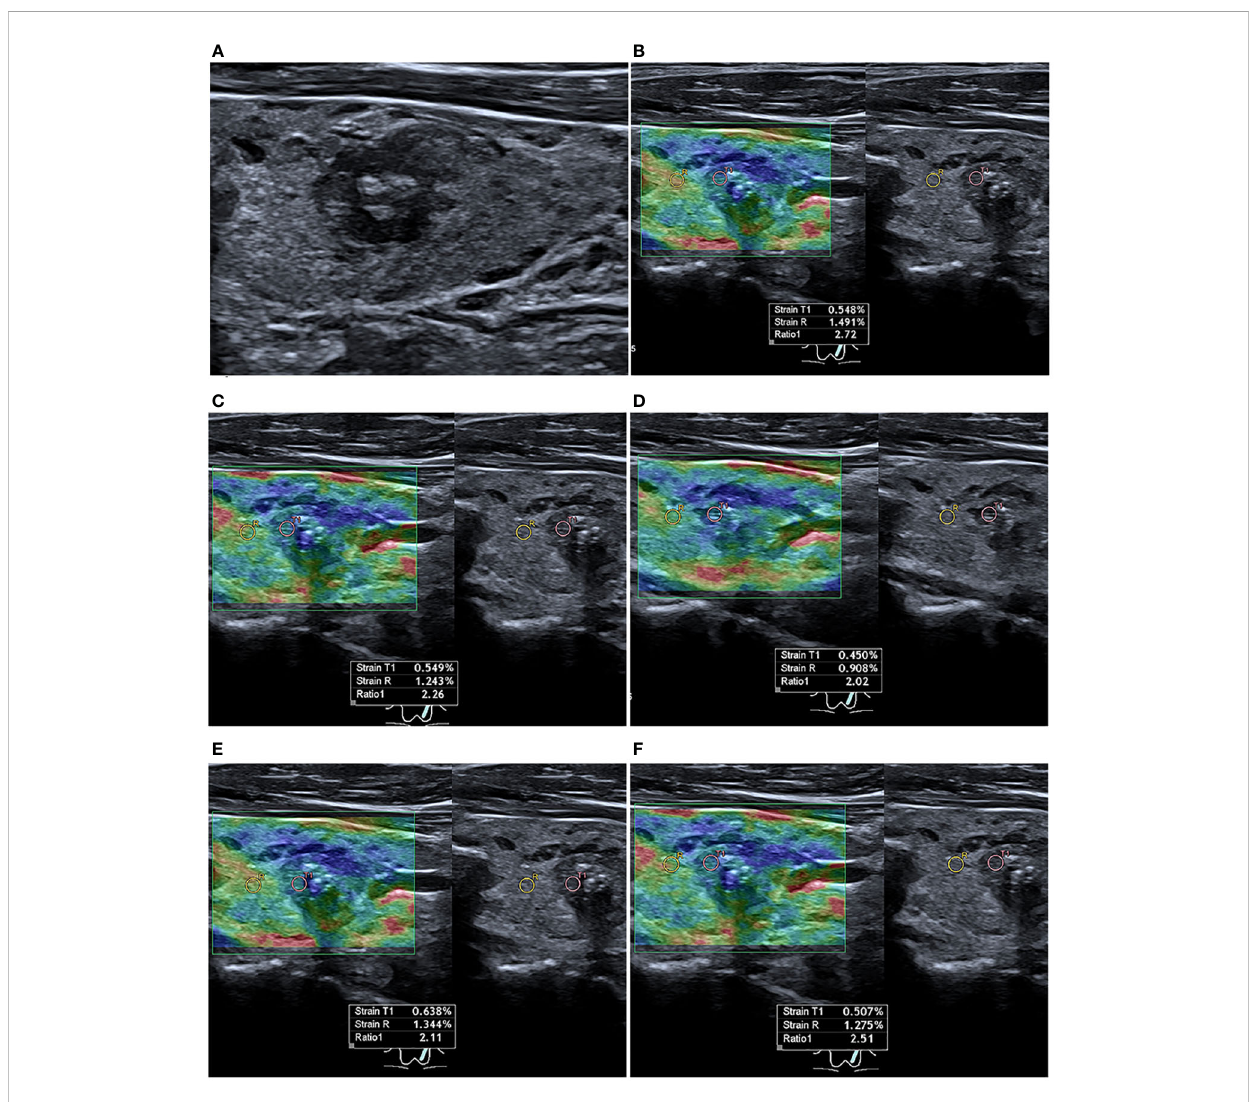
FIGURE 4 Conventional and strain ultrasound elastography of a 51-year-old male PTC patient with occult central cervical lymph node metastasis. (A) Conventional ultrasound shows a hypoechoic nodule in the lower left lobe of the thyroid gland with a maximum diameter of 12.30 mm. (B – F) Five strain ultrasound elastography images were obtained, with strain ratios of 2.72, 2.26, 2.02, 2.11, and 2.51,